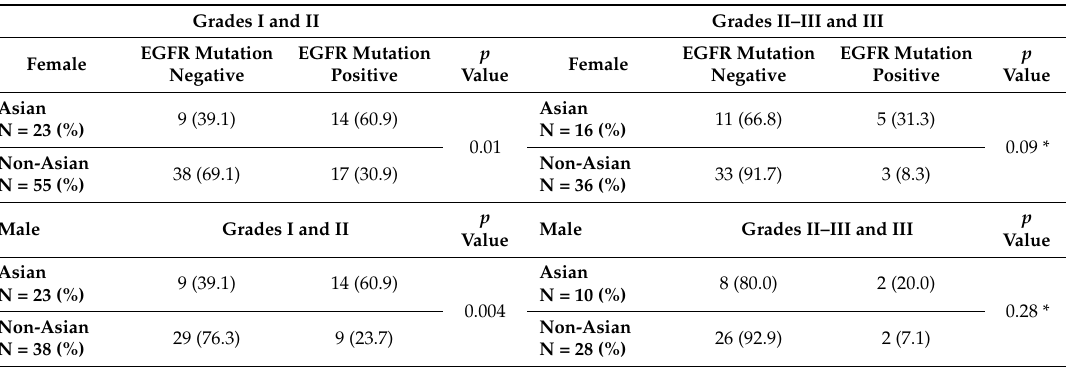
Table 4. Incidence of EGFR mutation by histologic grade and ethnicity in female and male patient with metastatic lung